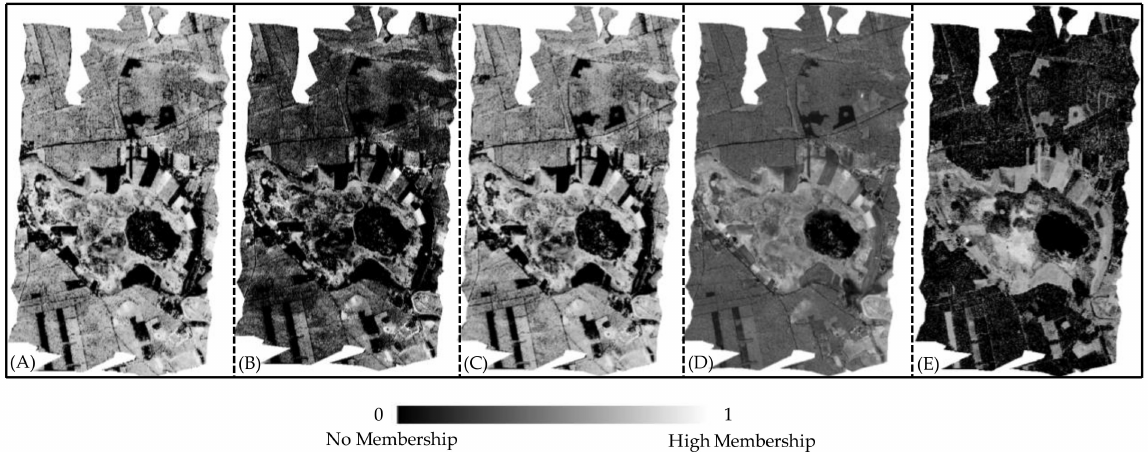
Figure 5. Membership maps of the different SVIs: ( A ) MF_NDVI; ( B ) MF_SR; ( C ) MF_NDVIre; ( D ) MF_EVI and ( E ) MF_PRI, derived from the fuzzy membership transformation functions. The membership maps ranging from 0 to 1 represent no membership to high membership,